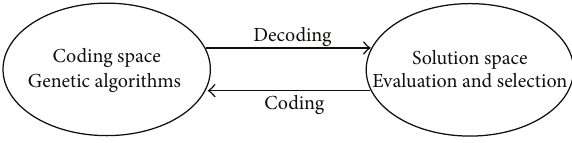
Figure 2: Coding space and solution